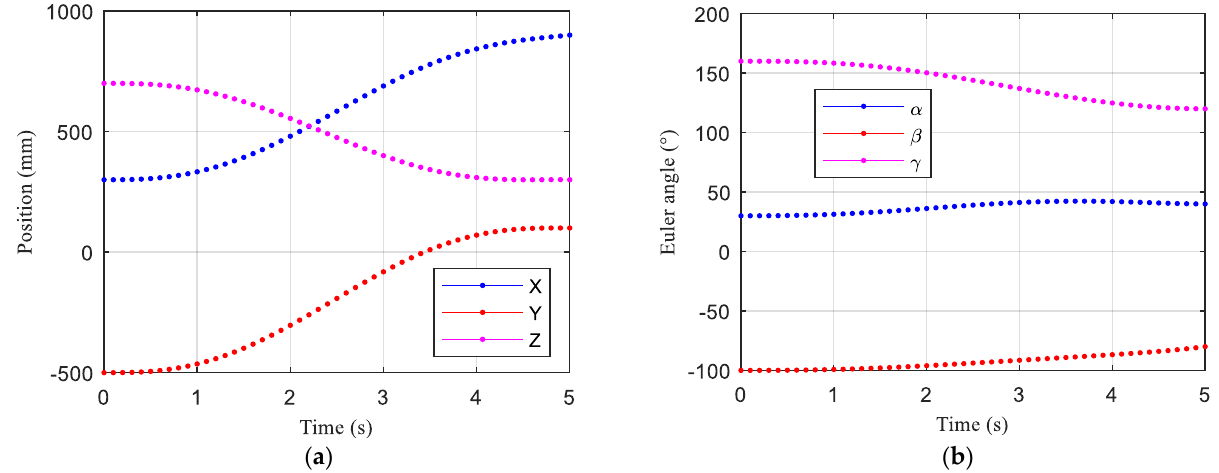
Figure A4. The real-time trajectory of the end effector of the humanoid manipulator. ( a ) The real-time position of the end effector; ( b ) The real-time Euler angle of the end effector.